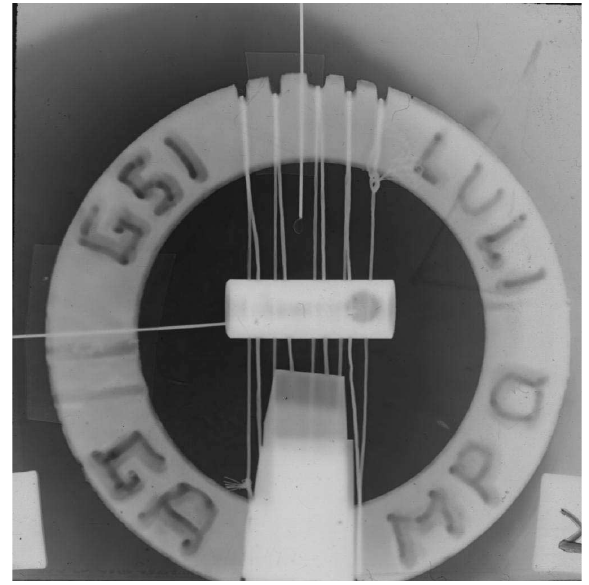
FIG. 6. Radiography of a compound target. Details of the target are given in the